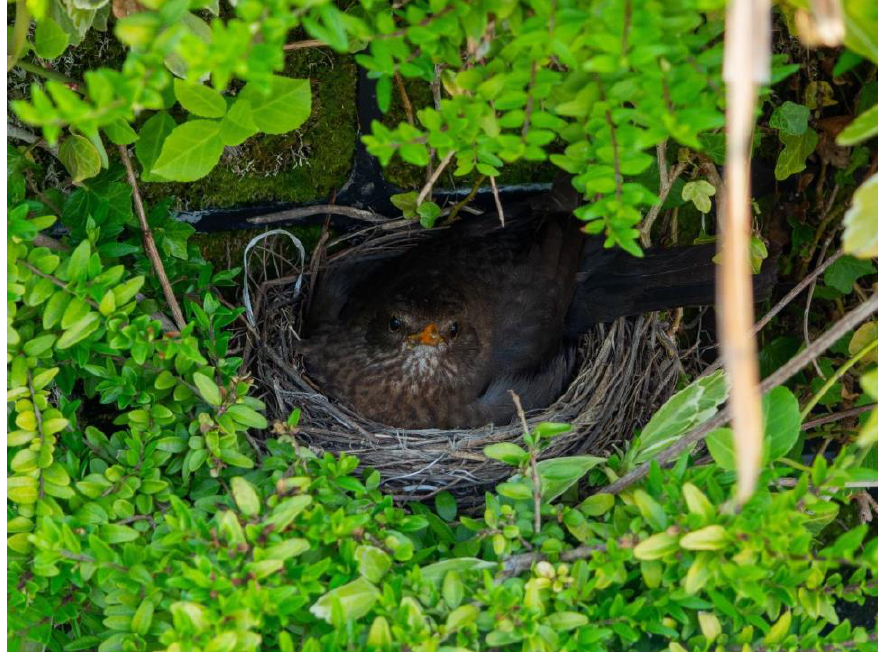
Figure 5. Nesting site of a blackbird ( Turdus merula ) on LW: a positive from an environmental point of view, but a possible conflict from a socio-cultural point of view. Author: Adéla Brázdová